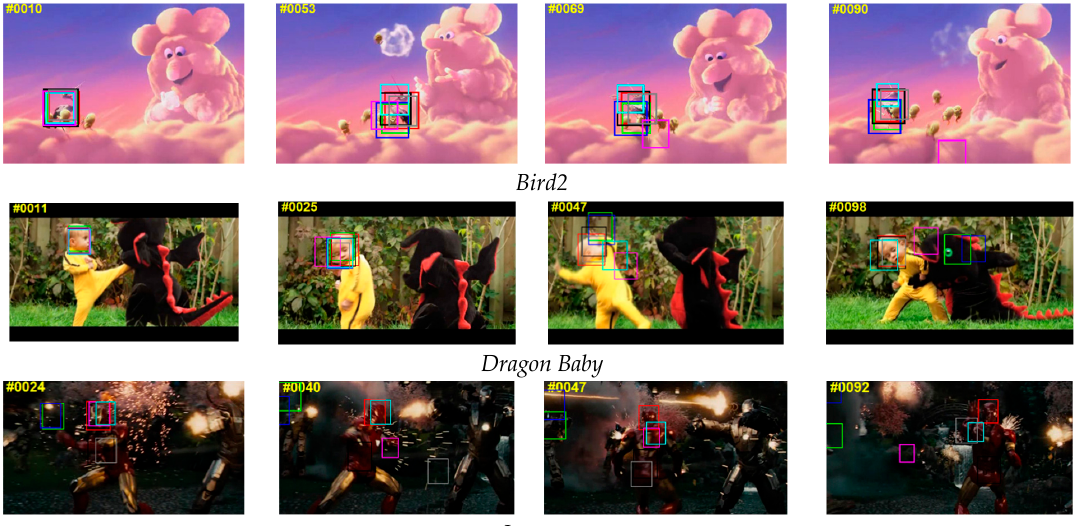
Figure 5. Attribute-based evaluation of the distance precision and overlap success plots compare the proposed algorithm with 13 state-of-the-art trackers over four video attributes of ( a ) background clutter, ( b ) occlusion, ( c ) in-plane rotation, ( d ) illumination variation, and ( e ) scale variation.